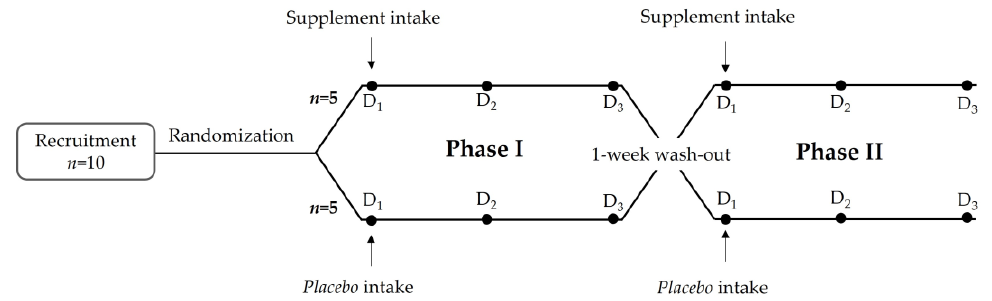
Figure 1. General flow diagram of the study.